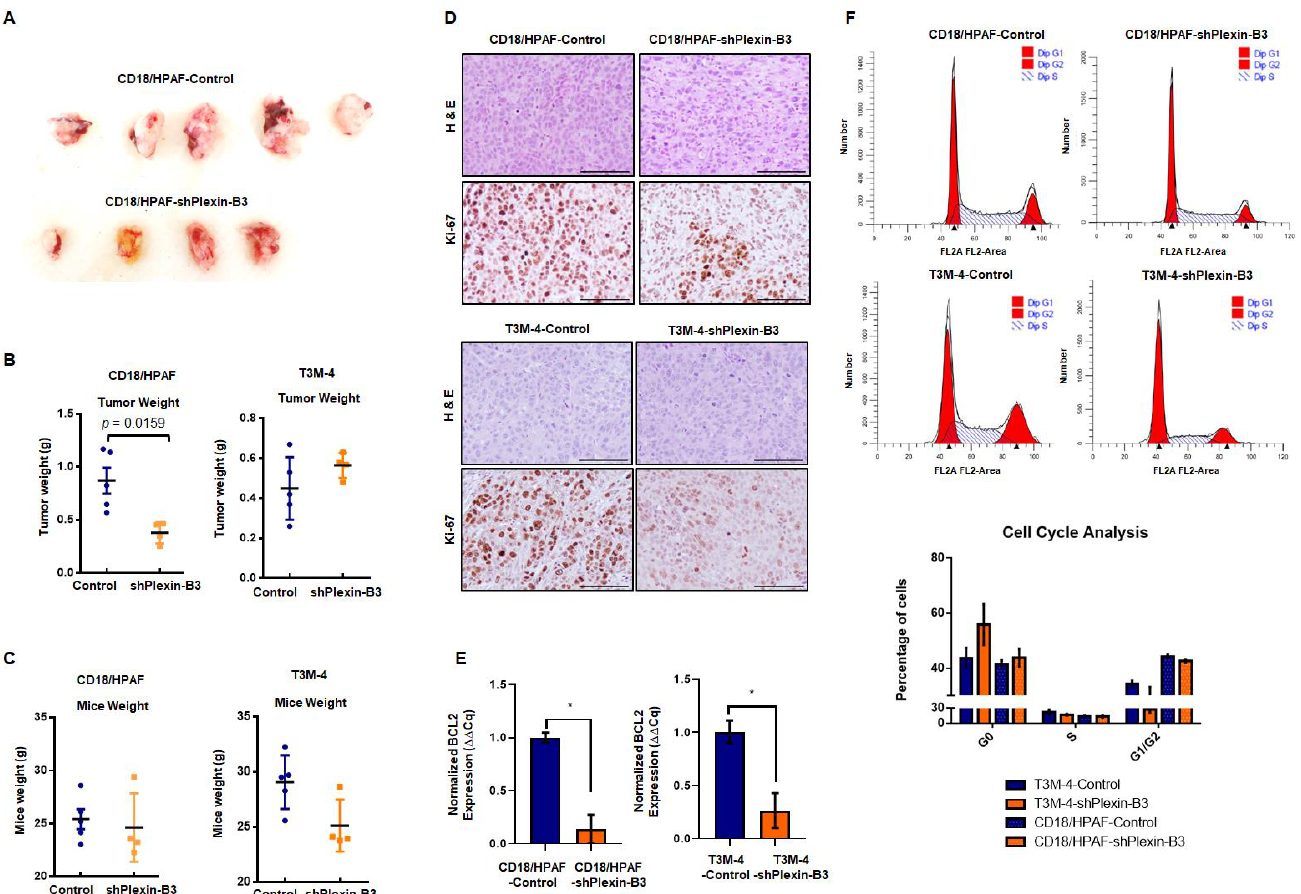
Figure 4. Loss of Plexin-B3 in PC cells results in a lower tumor burden in comparison with control cells. ( A ) Representative image of tumors formed from the injection of CD18/HPAF-Control and CD18/HPAF-shPlexin-B3 cells in athymic nude mice. The image shows the bigger tumor size of CD18/HPAF-Control cell-derived tumors in comparison with CD18/HPAF- shPlexin-B3-derived tumors. ( B ) Graph showing the average tumor weight of five different mice in each CD18/HPAF- Control and CD18/HPAF-shPlexin-B3 group and T3M-4-Control and T3M-4-shPlexin-B3 group. The graph shows a lower tumor burden of the CD18/HPAF-shPlexin B3 group in comparison with the CD18/HPAF-Control cells ( p = 0.0162). ( C ) Graph showing the average mice weight of five different mice in each CD18/HPAF-Control and CD18/HPAF-shPlexin- B3 group and T3M-4-Control and T3M-4-shPlexin-B3 group. The graph shows no statistical difference in the mice weight of the T3M4- or CD18/HPAF-shPlexin-B3 cells-injected groups and their respective control cells-injected group. The graph’s values represent the tumor weight or mice weight, and error bars in the graphs represent the SEM. The statistical p -value was calculated using a nonparametric Mann–Whitney U test. ( D ) Representative images of Ki-67 IHC and H&E staining of the primary tumor burden formed by the CD18/HPAF-shPlexin-B3 or -control cells and T3M-4 -shPlexin-B3 or T3M-4 control cells showing lower Ki67-positive cells in the shPlexin-B3 group in comparison with their control cells group. The scale bar represents 100 µ m. ( E ) Bar graph showing the relative fold decrease in the mRNA expression of BCL2 in CD18/HPAF- and T3M4-shPlexin-B3 samples compared with their respective controls. HPRT is used as a control. The values are the mean relative fold changes ± SEM, bars (* p ≤ 0.05). ( F ) Flow cytometry showing a cell cycle analysis in CD18/HPAF-Control and CD18/HPAF-shPlexin-B3 cells and T3M-4-Control and T3M-4-shPlexin-B3 cells labeled with propidium iodide. The graph’s peaks correspond to the G1/G0 and G2/M phases of the cell cycle, while the dip represents the S-phase. The bar graph shows the percentages of unsynchronized CD18/HPAF or T3M-4-Control and CD18/HPAF or T3M-4-shPlexin-B3 in a different phase of the cell cycle. CD18/HPAF- or T3M-4-Control cells showed fewer cells in the S-phase than CD18/HPAF- or T3M-4-shPlexin-B3